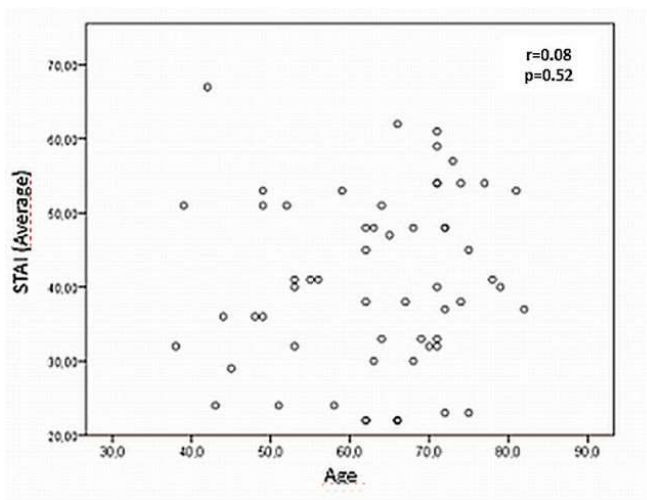
Figure 1. Correlation between anxiety scores and participants’ age. Table 2. Anxiety scores according to descriptive features of the studied